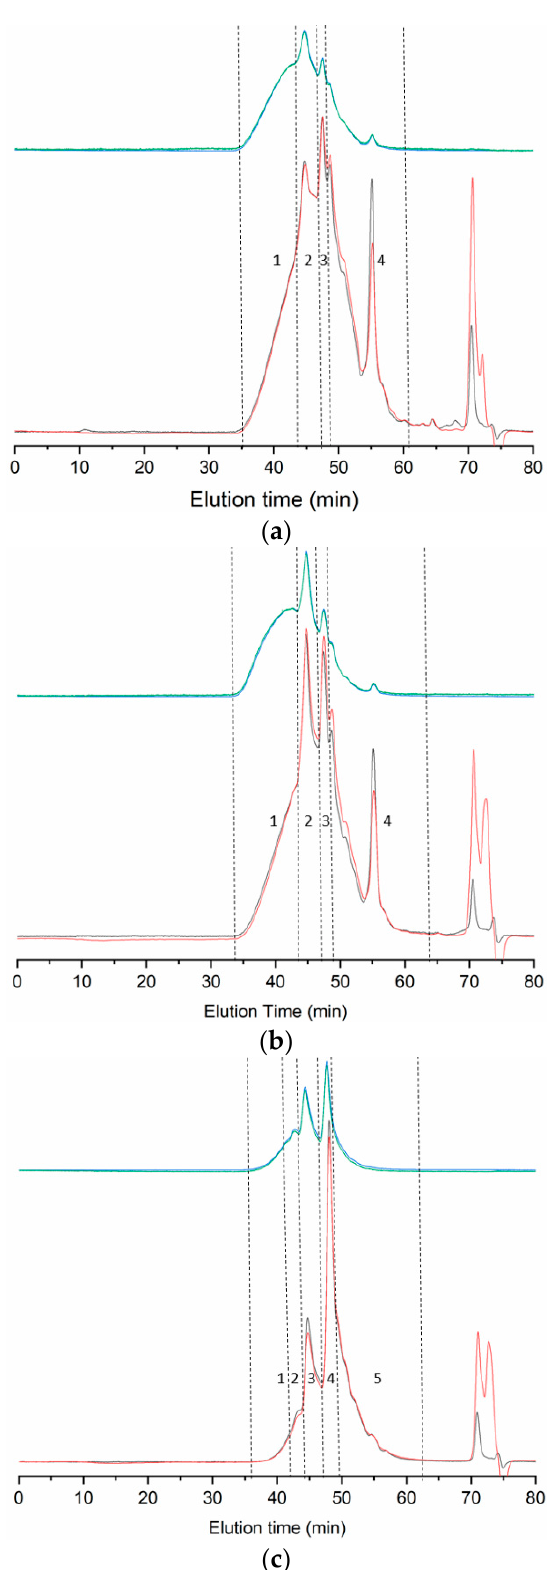
Figure 1. GPC eluograms of gelatin extracted from the skin of seabream ( a ), seabass ( b ), and trout ( c ). Blue line: right angle light scattering; green line: low angle light scattering; red line: refractive index; black line: ultraviolet (232 nm). Details about the numbered regions can be found in Table 2.